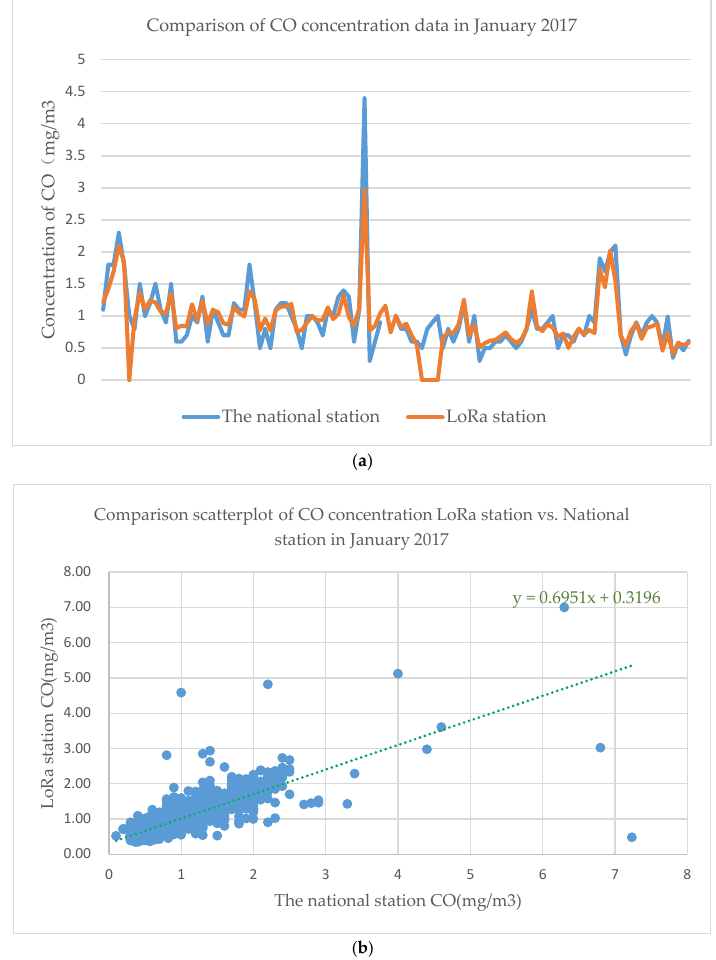
Figure 10. Comparison between the authoritative data that were issued by the national control station and the LoRa device station for the concentration of CO in a month. ( a ) Comparison line graph of the national station data and the LoRa CO data in a month. ( b ) Comparison scatter plot of the national station CO data and the LoRa CO data in month.